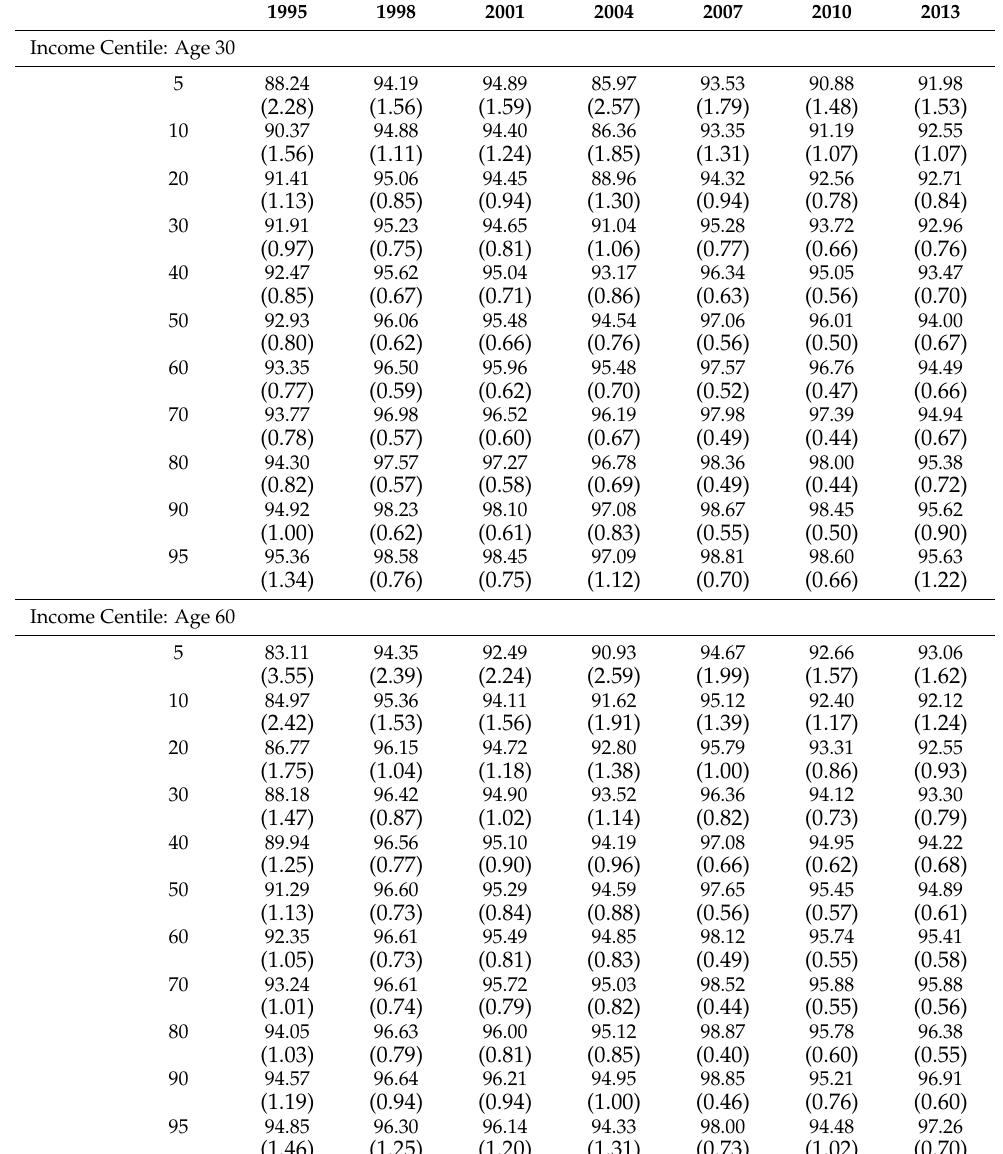
Table A9. Applications for Credit at Different Income Centiles for Young and